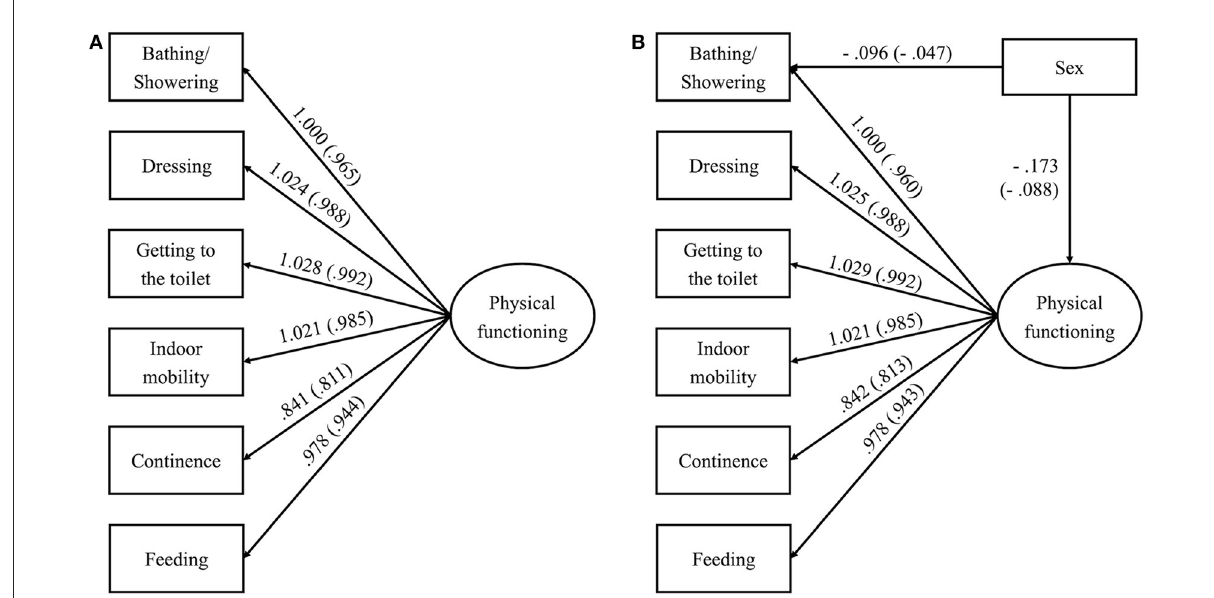
FIGURE1 (A) Measurement model of physical functioning. Results for the Confirmatory Factor Analysis (standardized results in brackets), all p s < 0.001. χ 2 (df) = 135.319 (9), p < 0.001; CFI = 1.000; TLI = 1.000; RMSEA = 0.038, 90% CI: [0.033, 0.044]; SRMR = 0.010. (B) Example MIMIC model linking sex to bath/showering. Results for the MIMIC model (standardized results in brackets), all p s < 0.001. χ 2 (df) = 170.292 (13), p < 0.001; CFI = 1.000; TLI = 0.999; RMSEA = 0.036, 90% CI: [0.031, 0.040]; SRMR = 0.013.